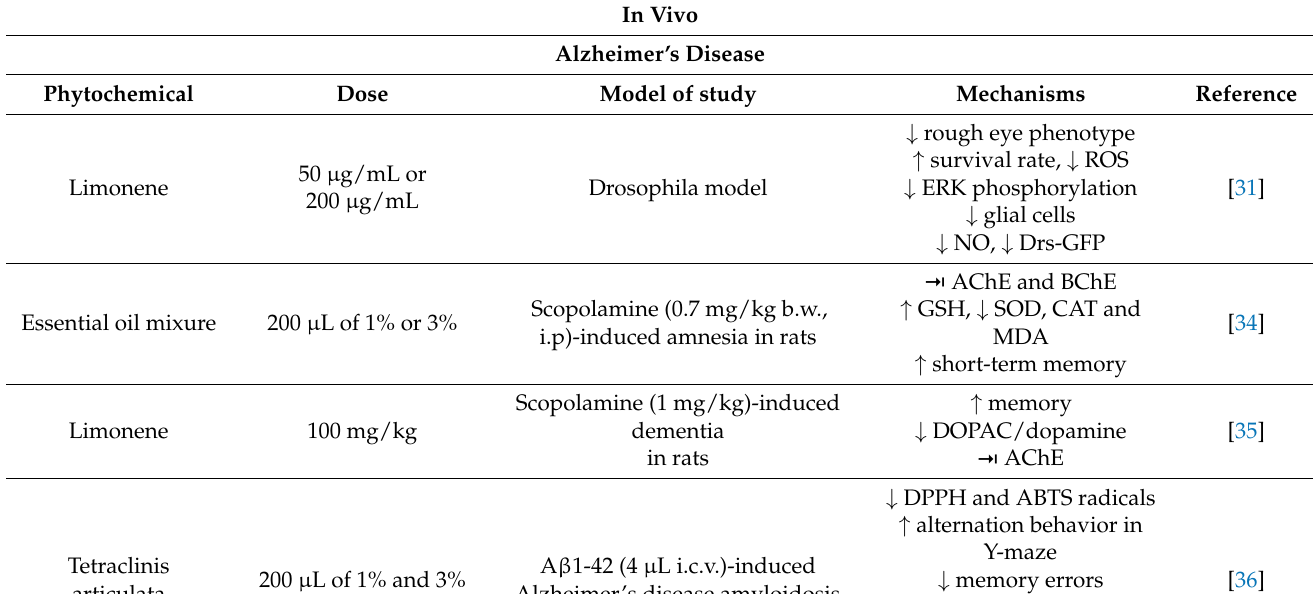
Table 2. The in vitro studies demonstrating the neuroprotective actions and mechanisms of limonene.